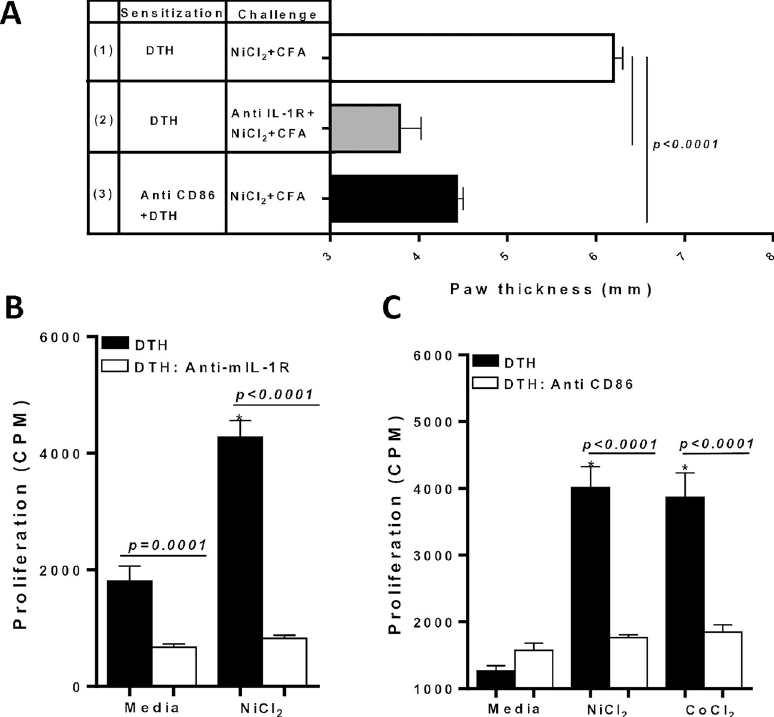
Fig 7. IL-1 and costimulatory signal by APCs are required for in vivo metal sensitization and for in vitro metal- reactive CD4+ T cells. (A) DTH was determined by measuring paw thickness 48 h after challenge in C57BL/6 mice that were sensitized and challenged as indicated on D 12. Sensitized mice in group 2 received local administration of antimIL-1R at the same time as challenge was delivered to the paw on D 12. Sensitized mice in group 3 received systemic ip injection of Anti-CD86 prior to metal sensitization and every 48 hrs until D 14. At D 14, spleens were harvested. CD4+ T cells were purified from the spleens of either DTH C57BL/6, (B) DTH C57BL/6 mice treated locally with antimIL-1Rr or (C) DTH C57BL/6 mice treated systemically with Anti-CD86 and co-cultured with mitomycin-C treated na ï ve total spleen cells from C57BL/6 with Ni (0.001mM) or Co (0.001mM) challenge for four days. Proliferation of CD4+ T cells was measured by 3 H-thymidine incorporation. Data represent one of three independent experiments with 3–4 mice/group in each experiment. Data are shown as mean ± SEM. Statistical significance was determined by Student’s unpaired two-tailed t-test ( � P �